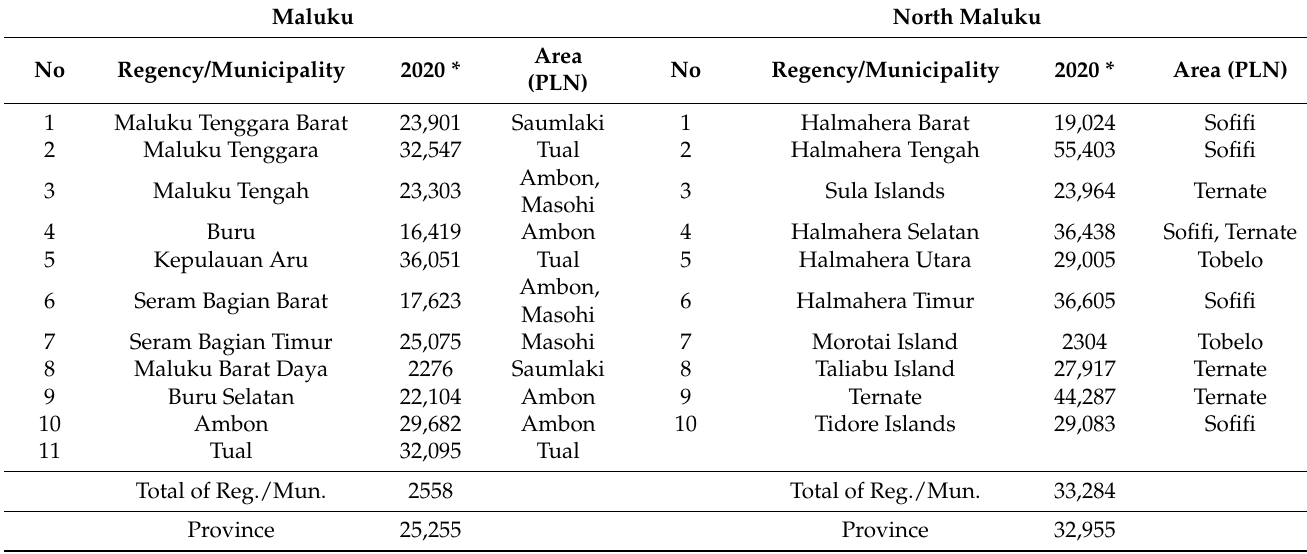
Table A1. Per capita gross regional domestic product (GRDP) by regency/municipality (in thousands rupiahs) [36].